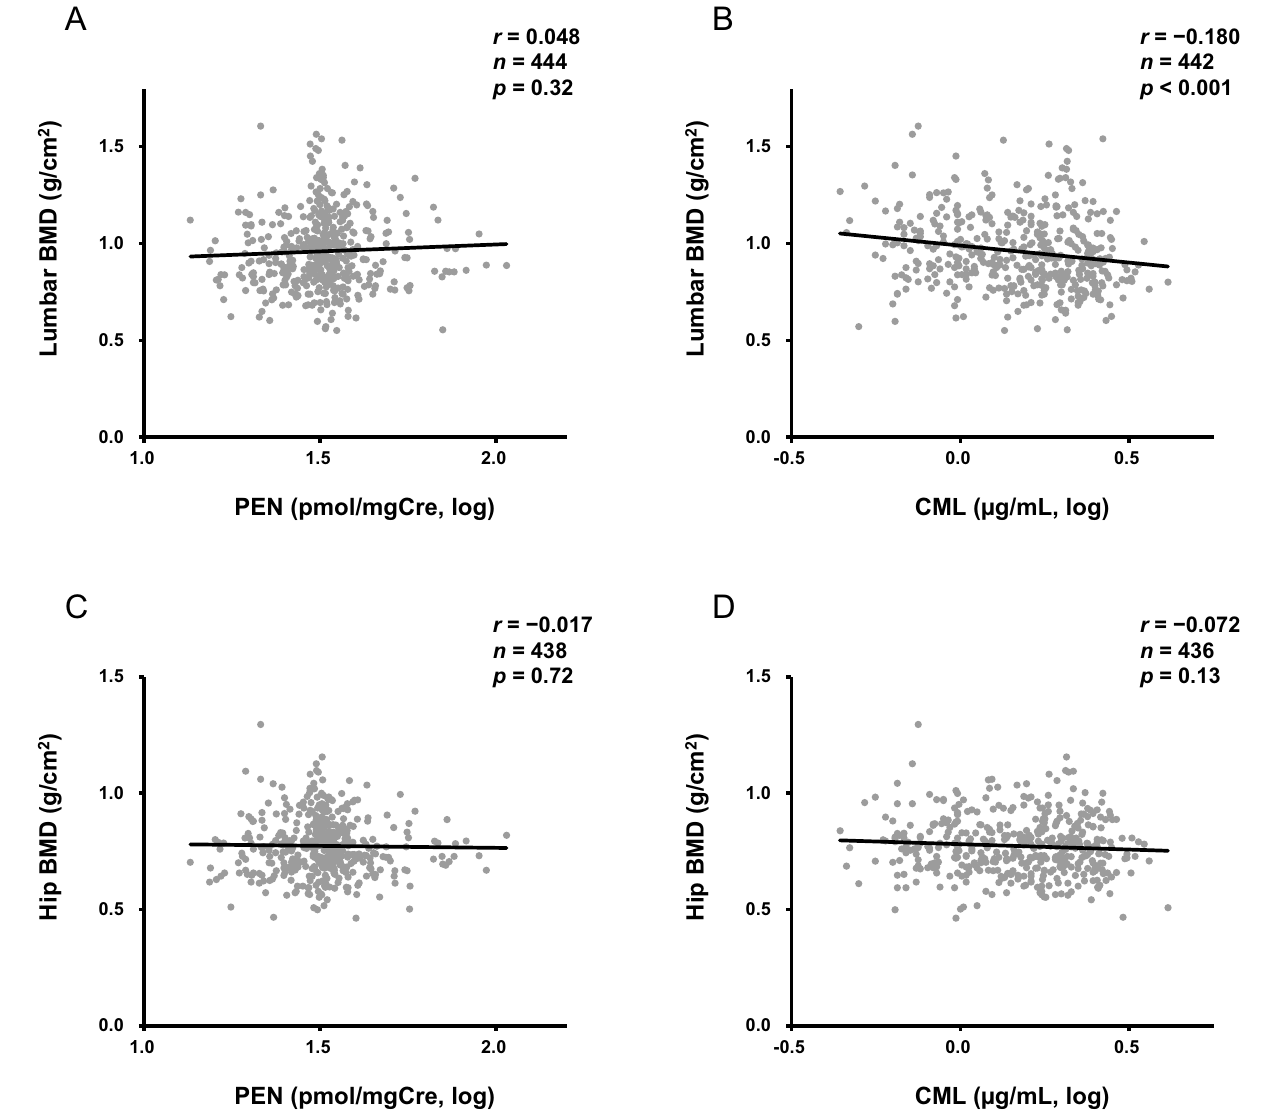
Figure 1. Correlations between AGEs and BMD. The correlation coefficients of ( A ) urinary PEN and ( B ) serum CML for lumbar BMD were 0.048 ( P = 0.32) and − 0.180 ( P < 0.001), respectively, and those of ( C ) PEN and ( D ) CML for hip BMD were − 0.017 ( P = 0.72) and − 0.072 ( P = 0.13), respectively. AGEs advanced glycation end products, BMD bone mineral density, PEN pentosidine, CML